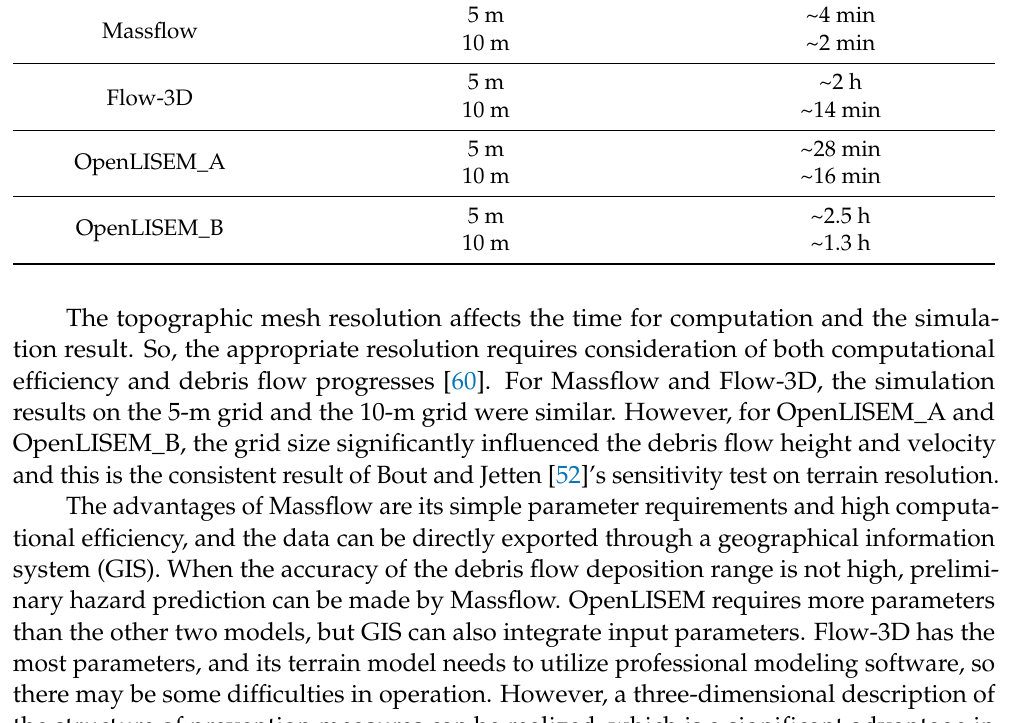
Table 5. With different mesh resolutions, the computational times required to simulate the debris flow event in 2013. Model Topographic Mesh Resolution Time for Computation 5 m ~4 min Massflow 10 m ~2 min 5 m ~2 h Flow-3D 10 m ~14 min 5 m ~28 min OpenLISEM_A 10 m ~16 min 5 m ~2.5 h OpenLISEM_B 10 m ~1.3